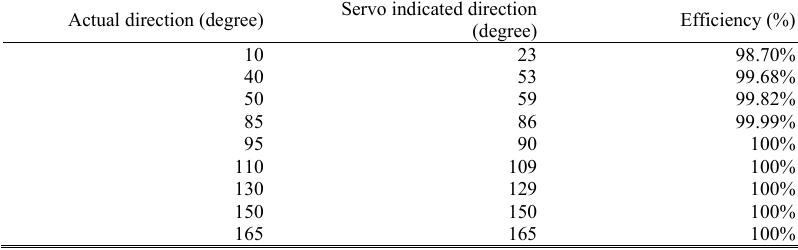
TABLE 4 A CCURACY M EASUREMENT OF D IRECTION OR A NGLE (D EGREE )